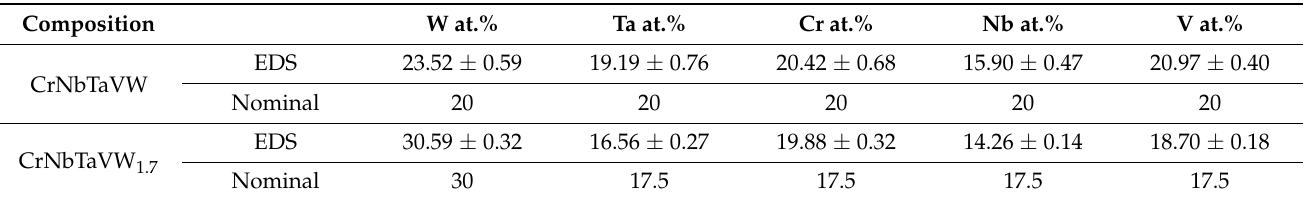
Table 3. Average elemental composition on the major phase obtained by EDS analysis for both CrNbTaVW and CrNbTaVW 1.7 compositions.